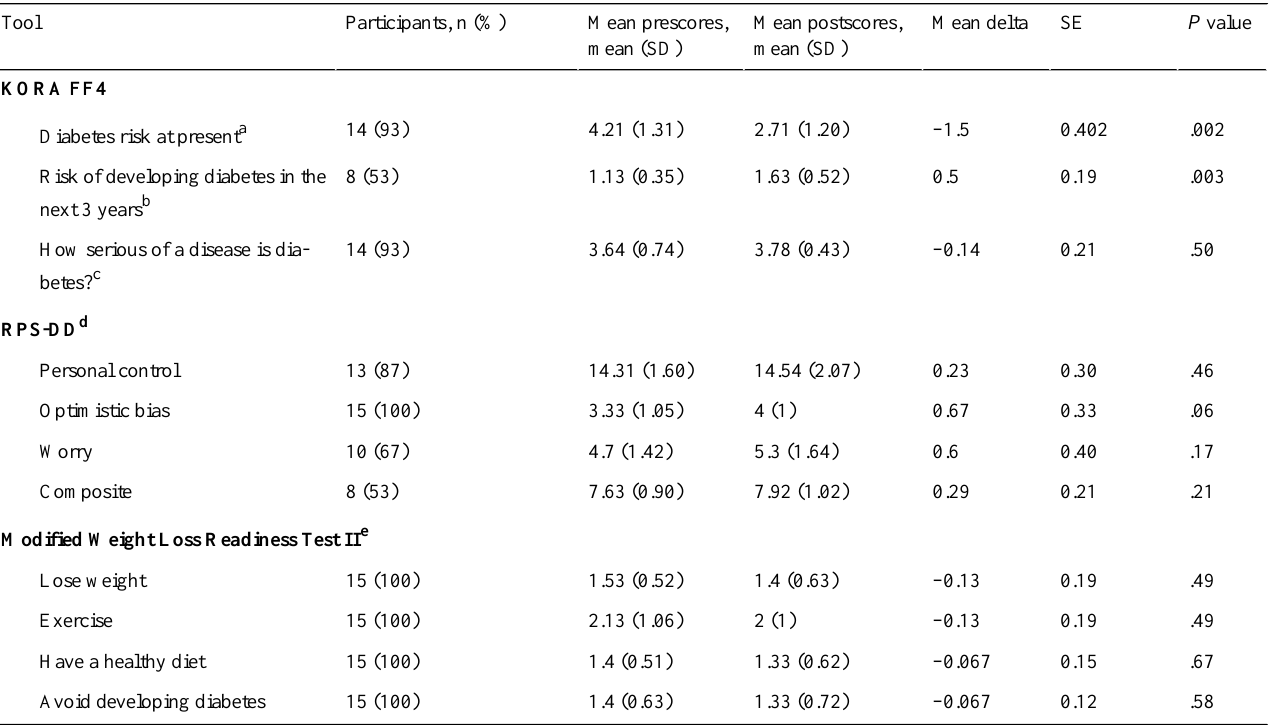
Table 3. Pre- and postscores of the KORA FF4, RPS-DD, and modified Weight Loss Readiness Test II.